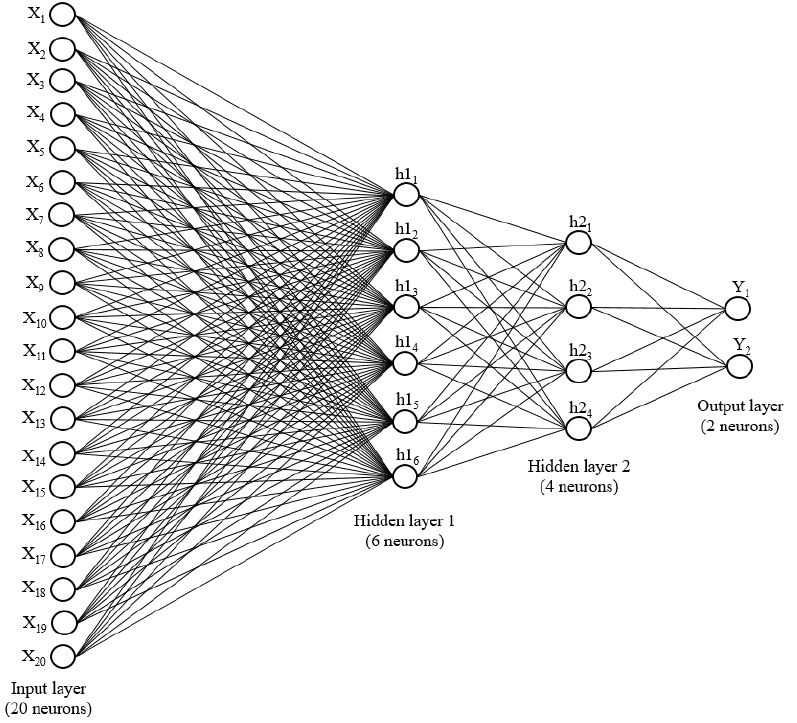
Figure 5. Deep neural network architecture.